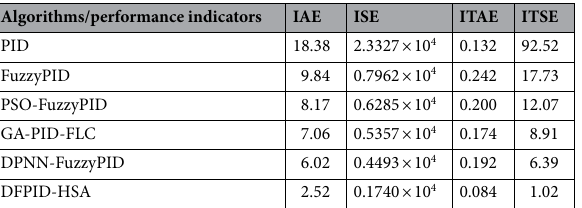
Table 6. Observed performance indices for error. IAE = ∫ |e(t)| dt, ISE = ∫ e 2 (t) dt, ITAE = ∫t |e(t)| dt, ITSE = ∫ te 2 (t) dt.